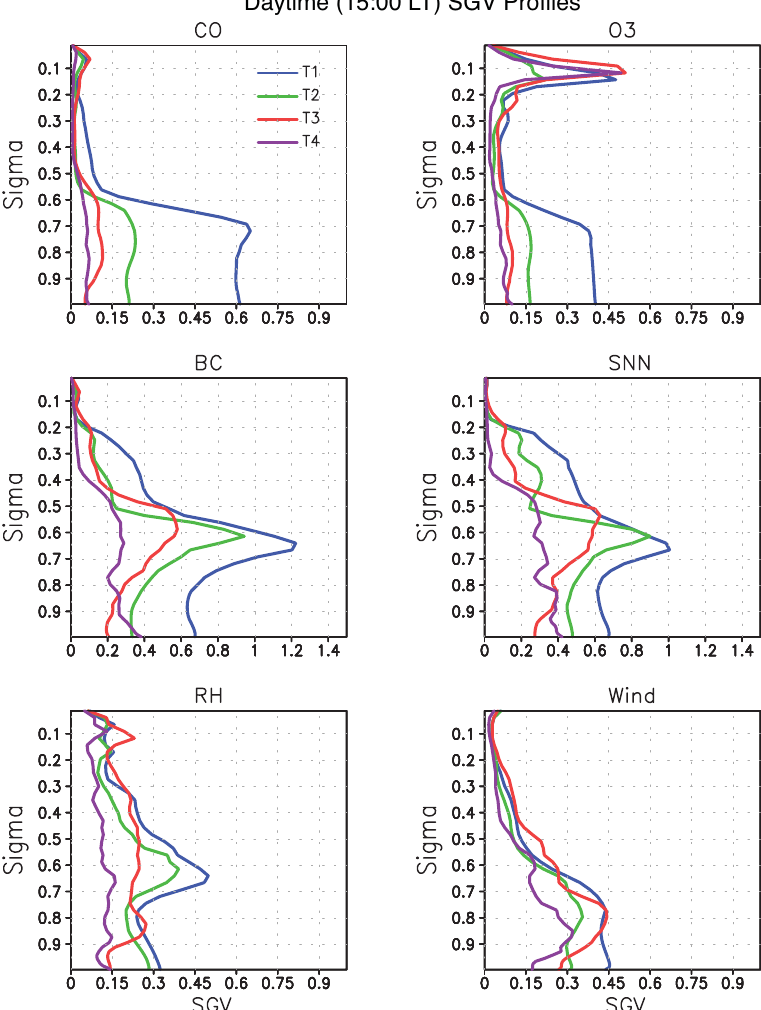
Fig. 11. Vertical profiles of SGV for CO, O 3 , BC, SNN, RH, and wind speed over T1, T2, T3, and T4 at 15:00LT. The vertical axis is the model η level, which makes comparison between the points easier, since each point is at a different elevation. The SGV is calculated from the single hour each day for the time period 5–30 March